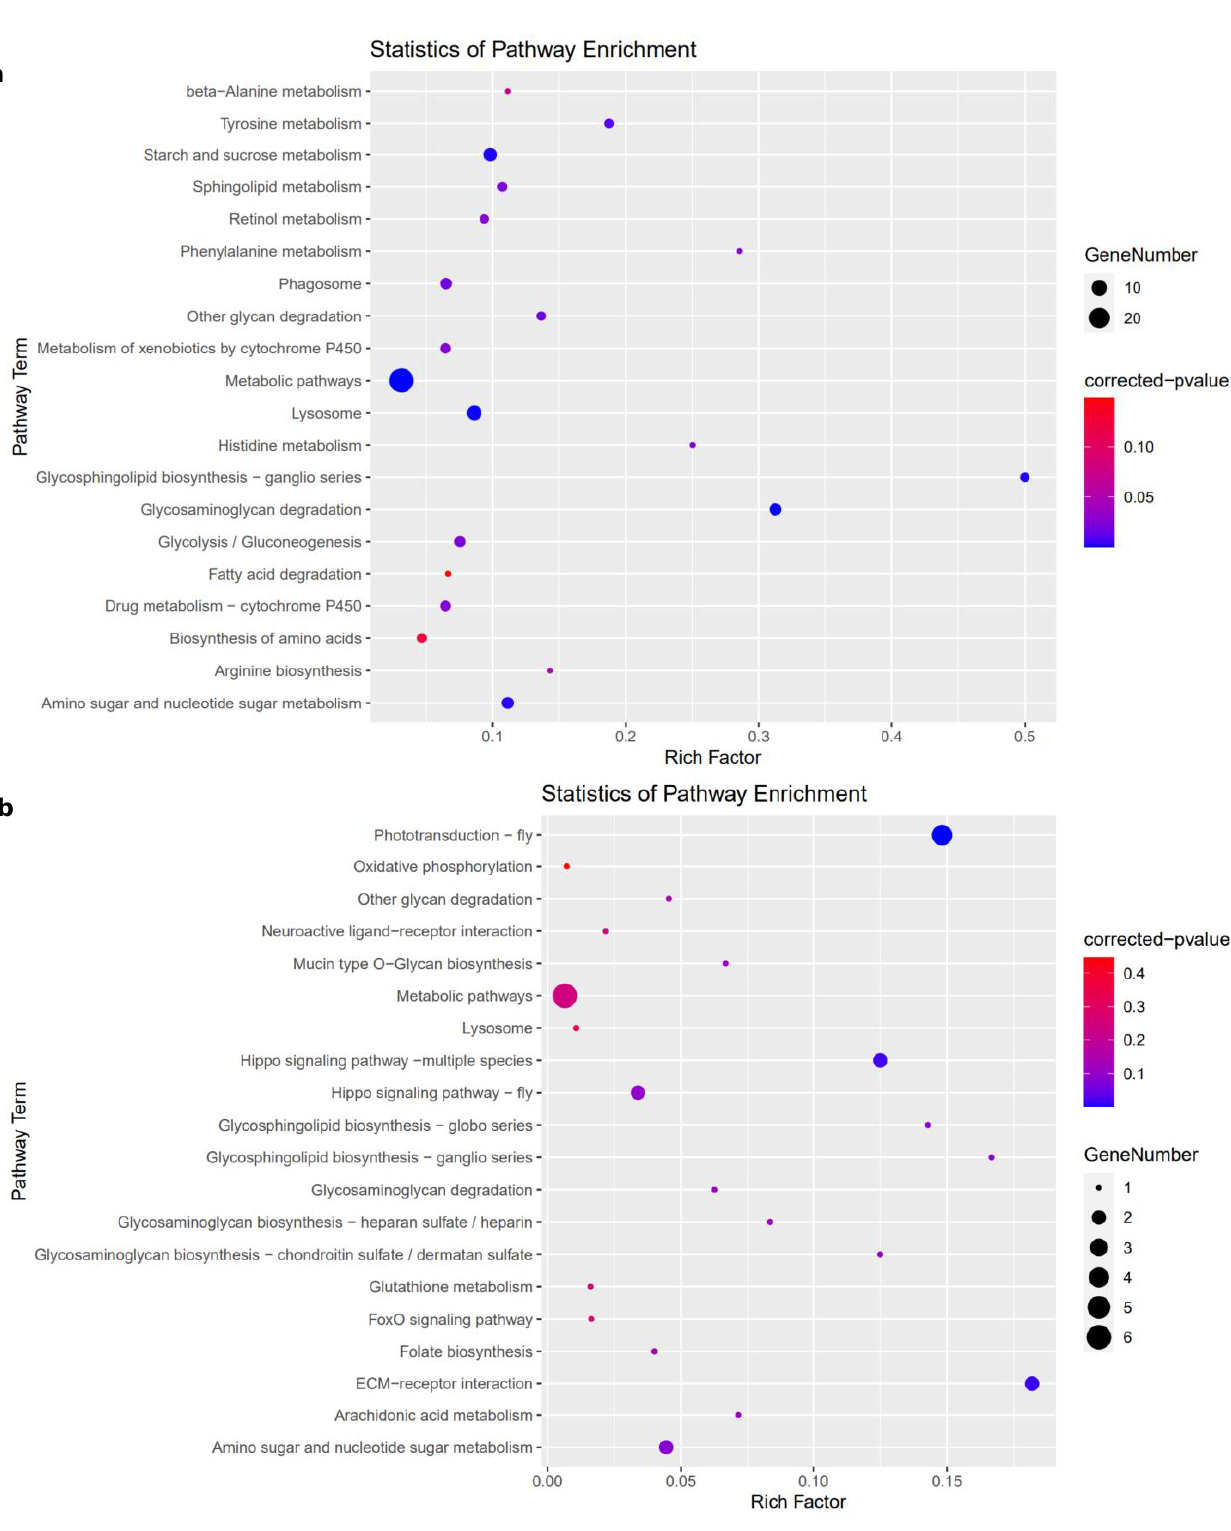
Figure 4. The KEGG significant enrichment pathway in LS _ O vs. CG _ O group. ( a ) Up-regulation pathways in LS _ O vs. CG _ O group.; ( b ) down-regulation pathways in LS _ O vs. CG _ O group.